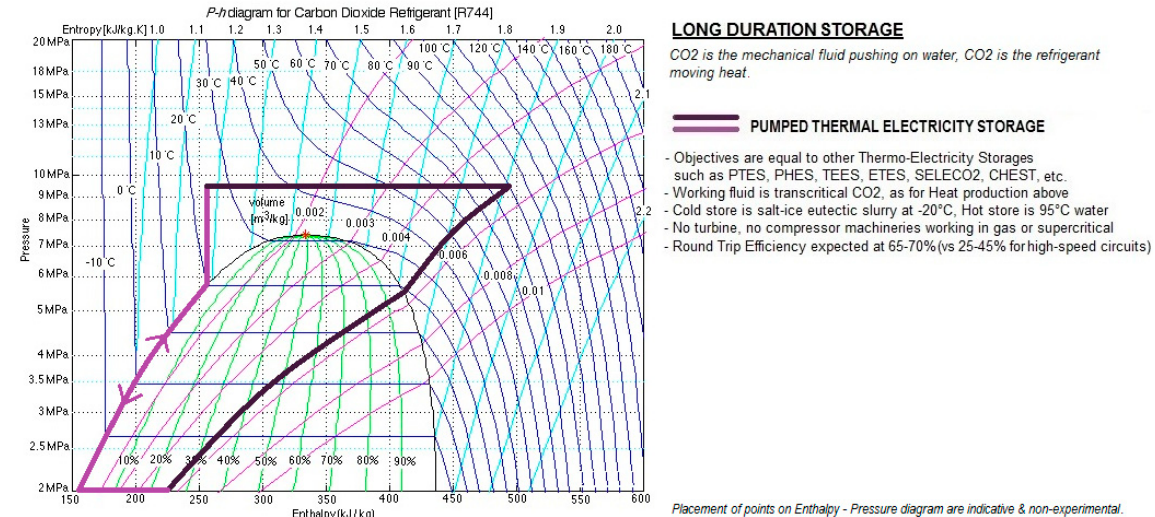
Figure 9. Operation of hybrid UPHES-PTES for long-duration storage, illustrated on the Pressure-Enthalpy diagram related to CO 2 .